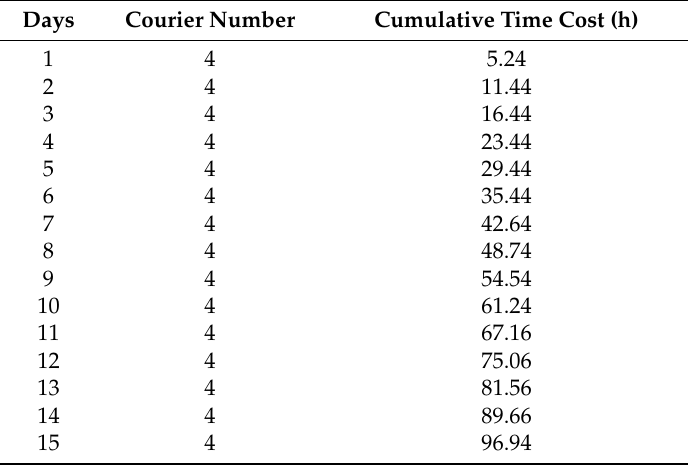
Table 6. Courier 4 cumulative time